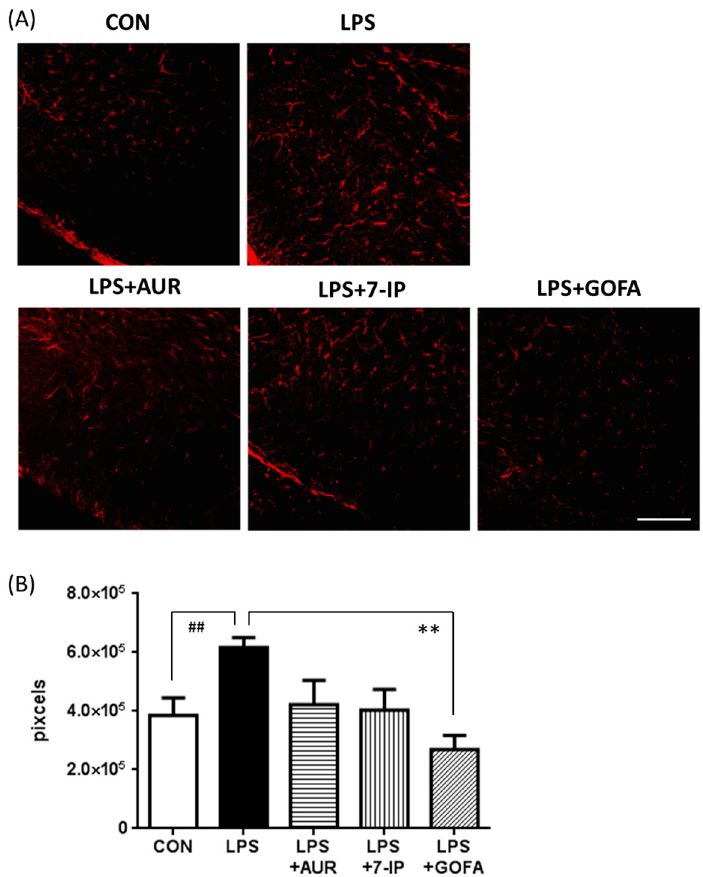
Figure 4. Effects of AUR, 7-IP, and GOFA on the LPS-induced activation of astrocytes in the substantia nigra. ( A ) Representative confocal micrographs of glial fibrillary acidic protein (GFAP)-positive cells on day 22 in the indicated groups. Scale bar = 100 µ m; ( B ) Total GFAP-positive cells signal densities. Values are the means ± SEM. Significant differences were observed between CON and LPS ( ## p < 0.01) and between LPS and sample treatment groups (** p < 0.01).